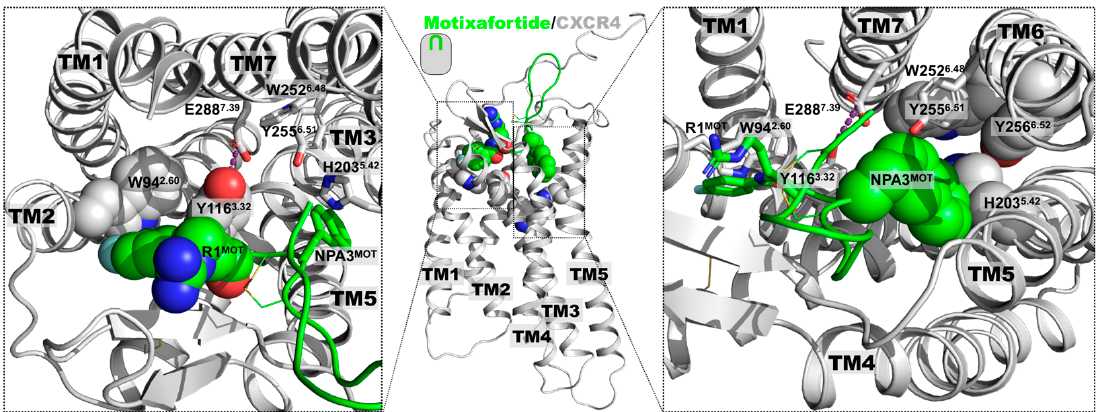
Figure 5. Interactions of the unnatural moieties of motixafortide: The two synthetic components in motixafortide are a 4-fluorobenzoyl group as an N-terminal capping group and a naphthalene derivate (NPA) sidechain at position 3 (see also Figure S7). The results from the unbiased MD simulations placed the two chemical moieties at different locations inside the orthosteric binding site (lateral view of the central panel). As shown in the left panel (extracellular view), the 4-fluorobenzoyl forms aromatic interactions with residues W94 2.60 and Y116 3.32 . The presence of the 4-fluorobenzoyl group restricts the conformation of this bulky residue, facilitating the interaction of the hydroxyl group of the Y116 3.32 sidechain with E288 7.39 (purple dashed line). As shown in the right panel (extracellular view), the NPA sidechain forms aromatic interactions with H203 5.42 , and it is placed in the vicinity of residues in TM6—particularly Y255 6.51 .